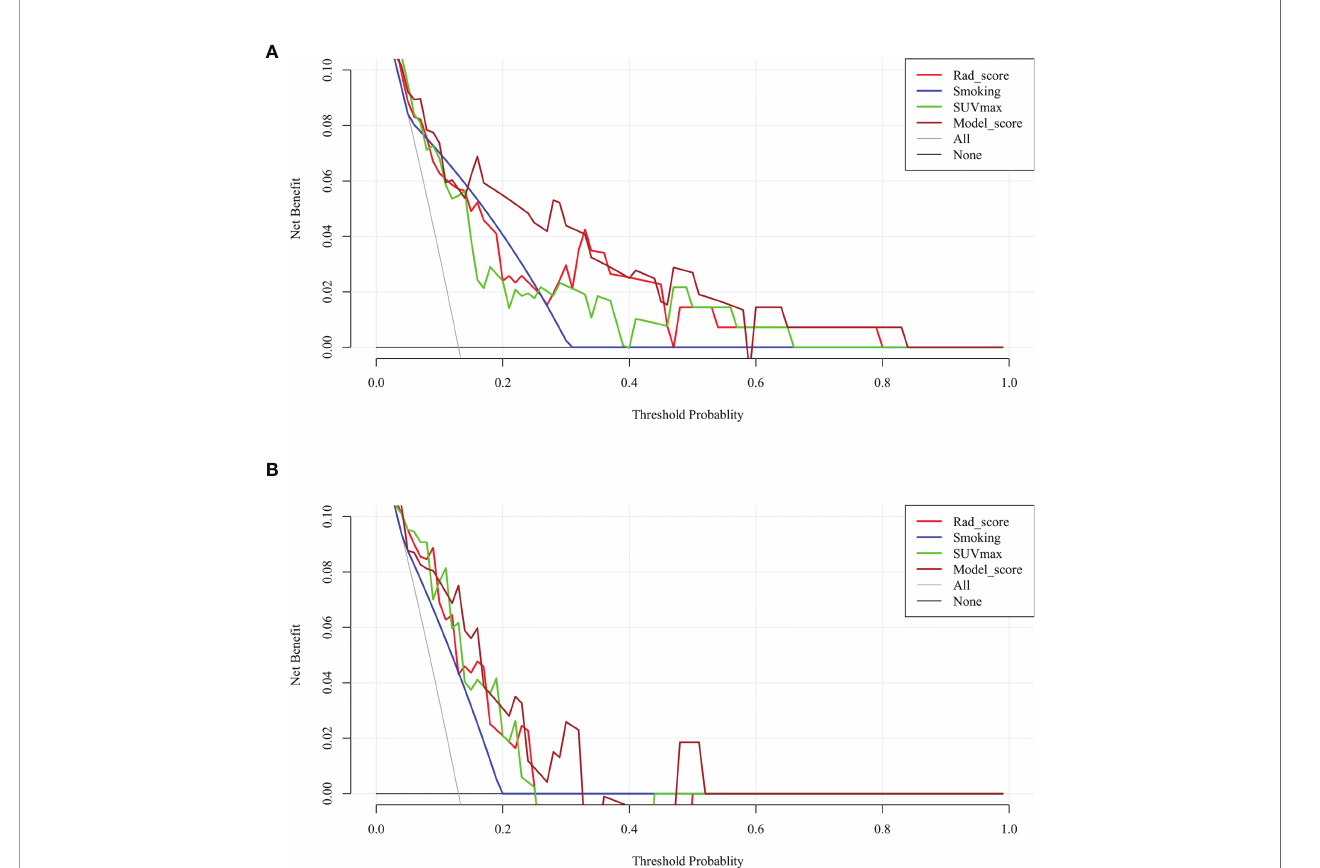
FIGURE 6 | Decision curve analysis (DCA) of each model in predicting tumor microenvironment immune type (TMIT)-I for non-small cell lung cancer (NSCLC). The vertical axis measures standardized net bene fi t. The horizontal axis shows the corresponding risk threshold. In the training set (A) , the DCA showed that if the threshold probability is between 0.1 and 0.8, using the complex model (brown line) provided a greater bene fi t than the clinical model (blue curve) and basic PET parameter (green curve). In the validation set (B) , the DCA showed that if the threshold probability is between 0.1 and 0.5, using the complex model provided a greater bene fi t than the clinical